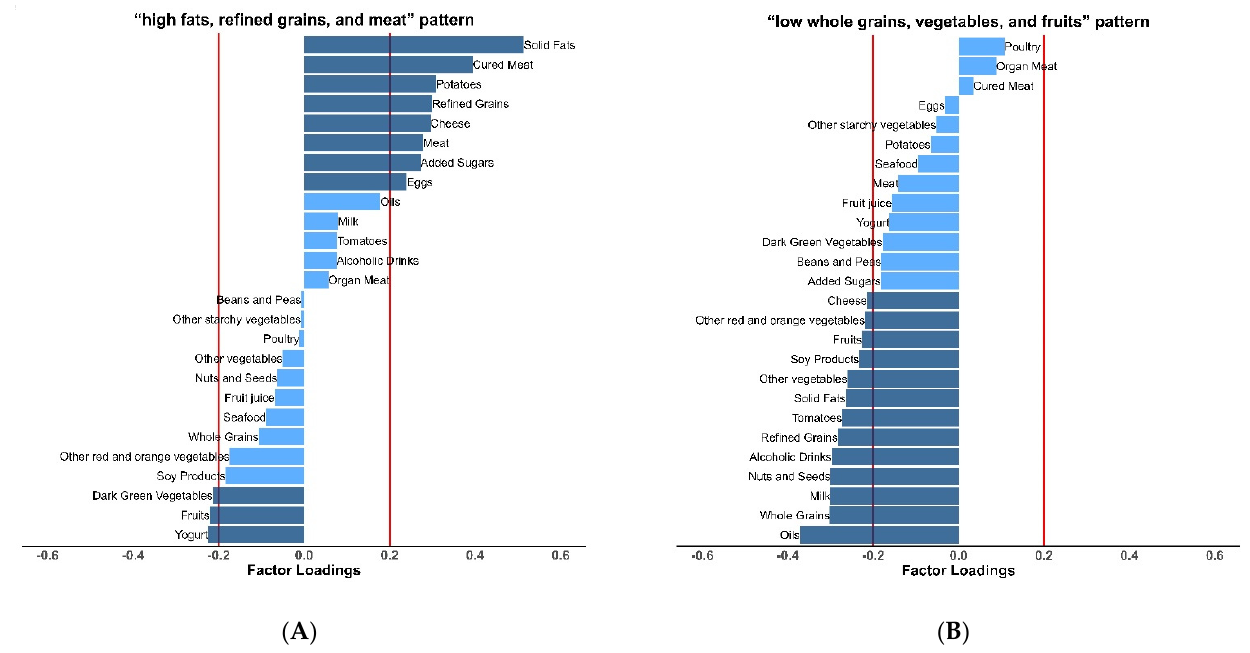
Figure 1. Factor loadings from partial least squares of food group intakes. The first dietary pattern was labeled the “high fats, refined grains, and meat” pattern ( A ). The second dietary pattern was labeled the “low whole grains, vegetables, and fruits” pattern ( B ). The darker color indicates that food groups with absolute values of factor loadings ≥ 0.20.